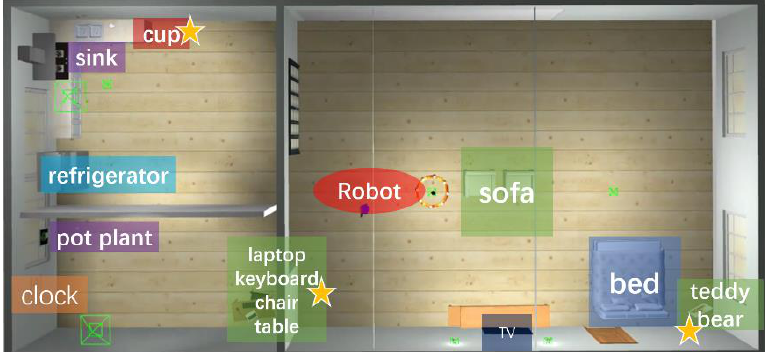
Figure 10. The virtual apartment this paper built.